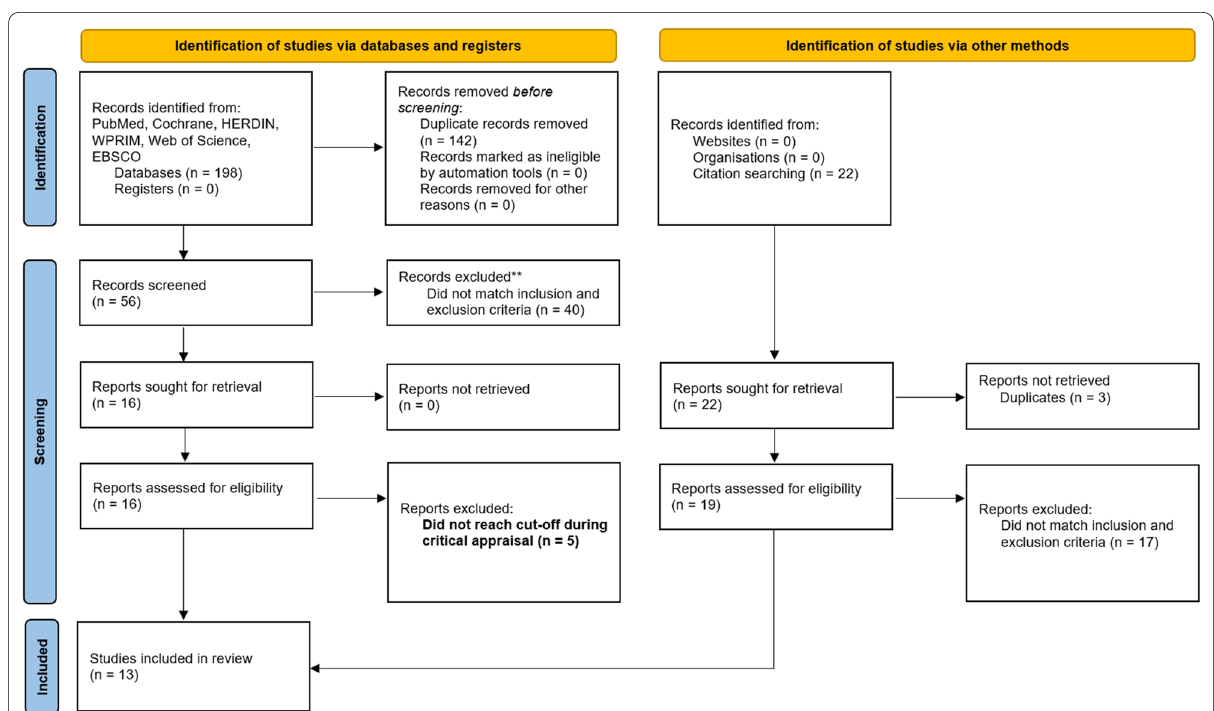
Fig. 1 PRISMA flow diagram for searches of databases, registers, and other